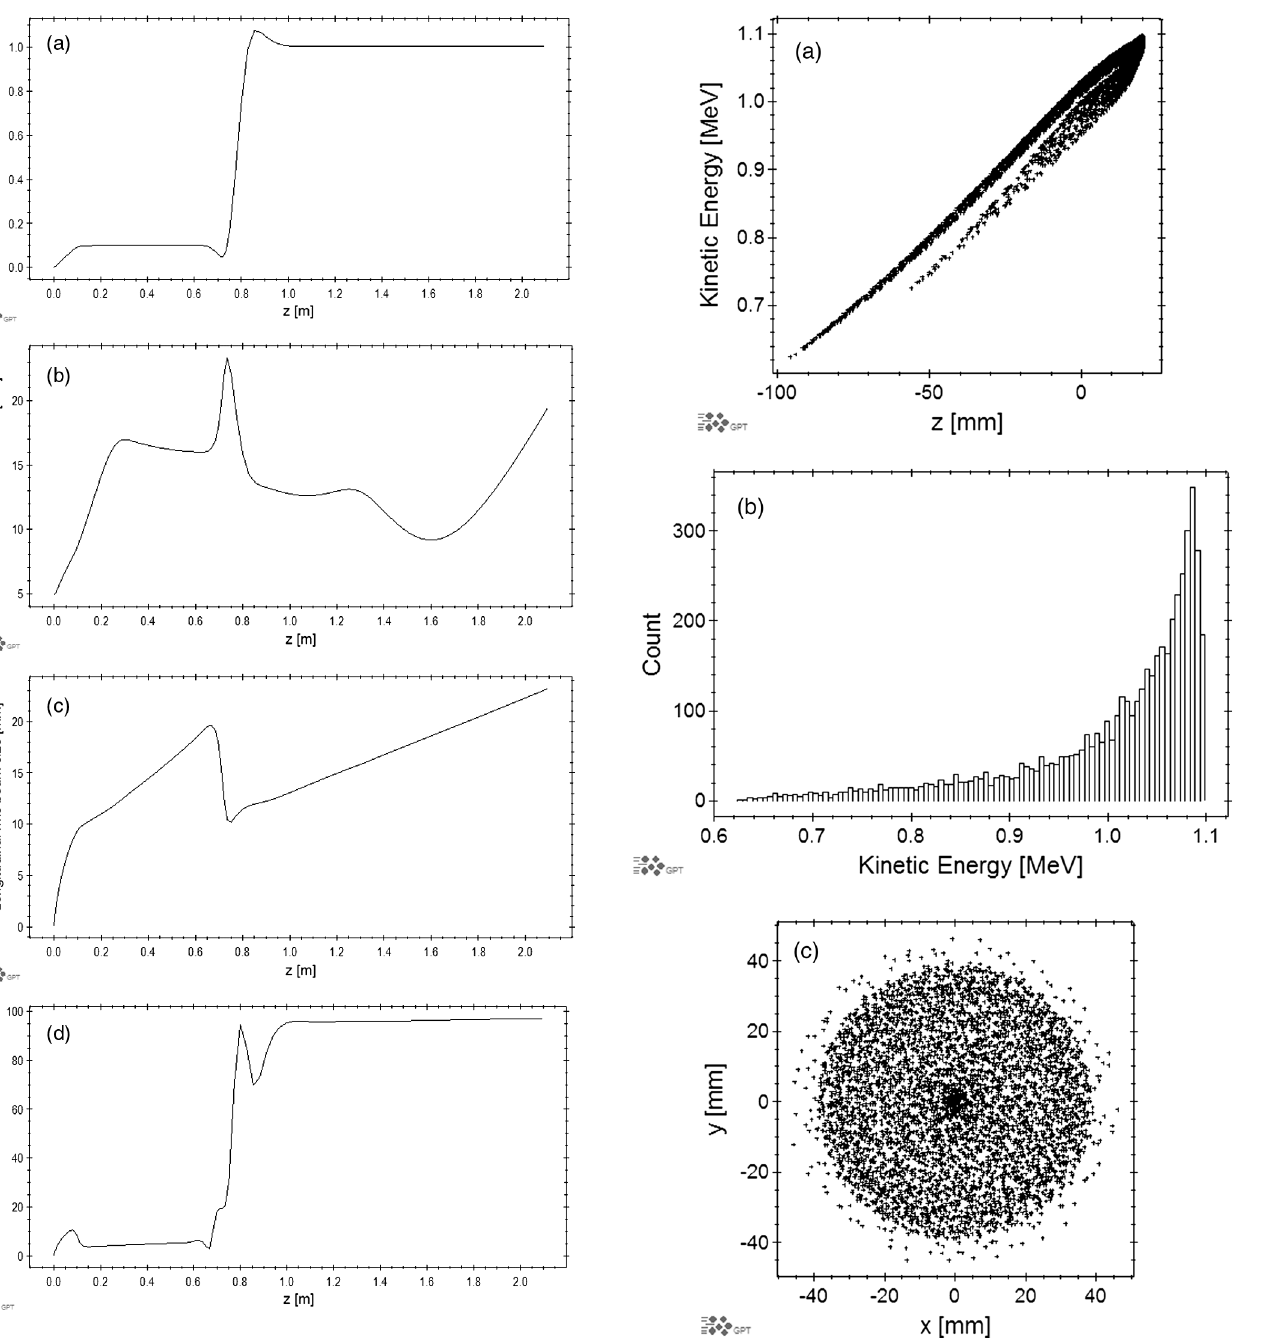
FIG. 5. Longitudinal phase space at 2.4 m from the cathode (a) and associated histogram (b). The transverse configuration space after the cavity is shown in